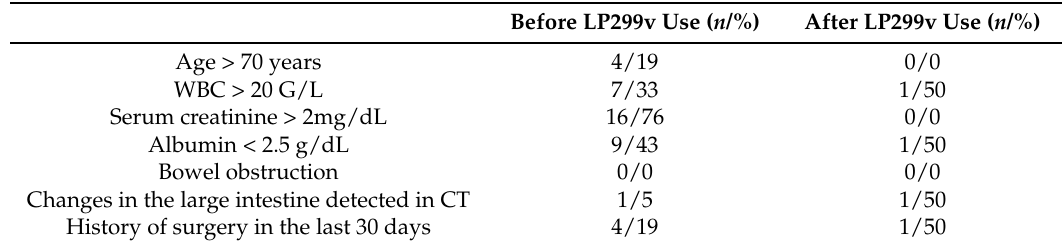
Table 3. Risk factors of severe course of CDI in the study group. Before LP299v Use ( n /%)